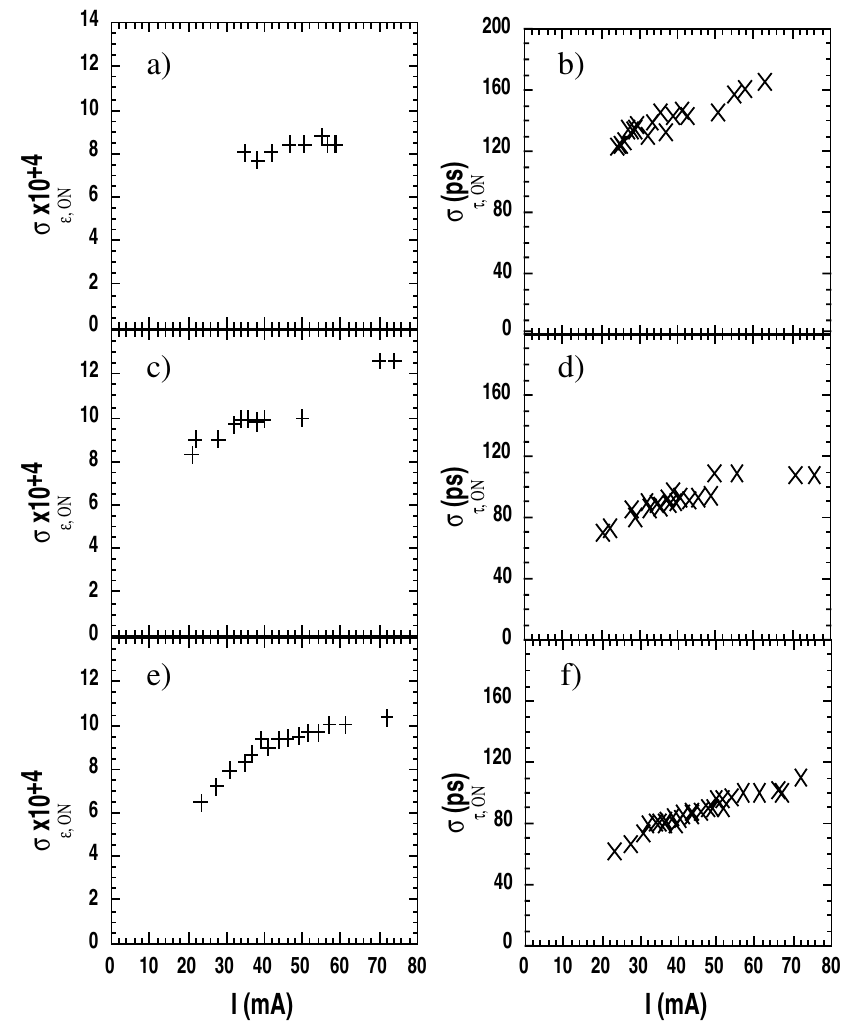
(cid:1) 0 kV ; (+) for (a) V (cid:2) h (cid:1) 90 kV ; (f) V (cid:1) 120 kV h h